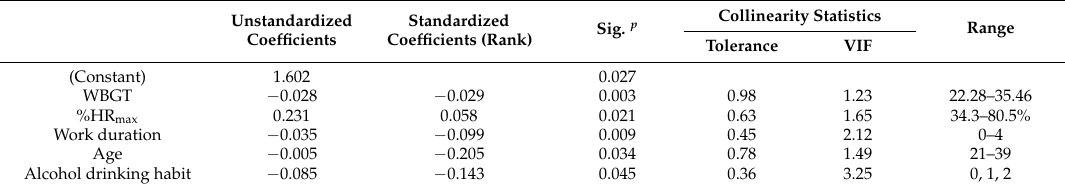
Table 6. MLP analysis for CLP-heat stress model ( n =